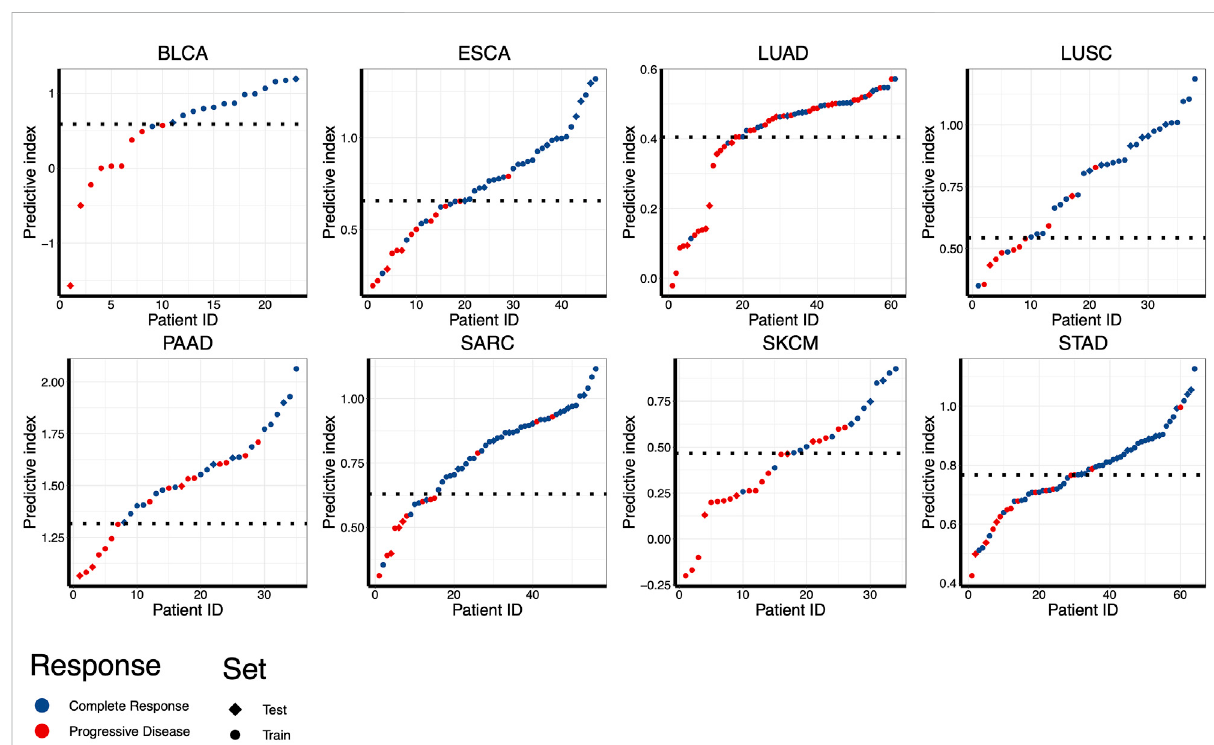
FIGURE 4 Assessing the performance for distinguishing RT responsive samples in eight different cancer types using combinatorial models. Predictive indexes were calculated to classify samples. Patients are shown in columns, and predictive index was showed in rows. The optimal cut-off value for distinguishingSandRsampleswasindicatedbyadottedline.Samplesoftrainingsetwereindicatedbycircles,andsamplesoftestsetwereindicated by